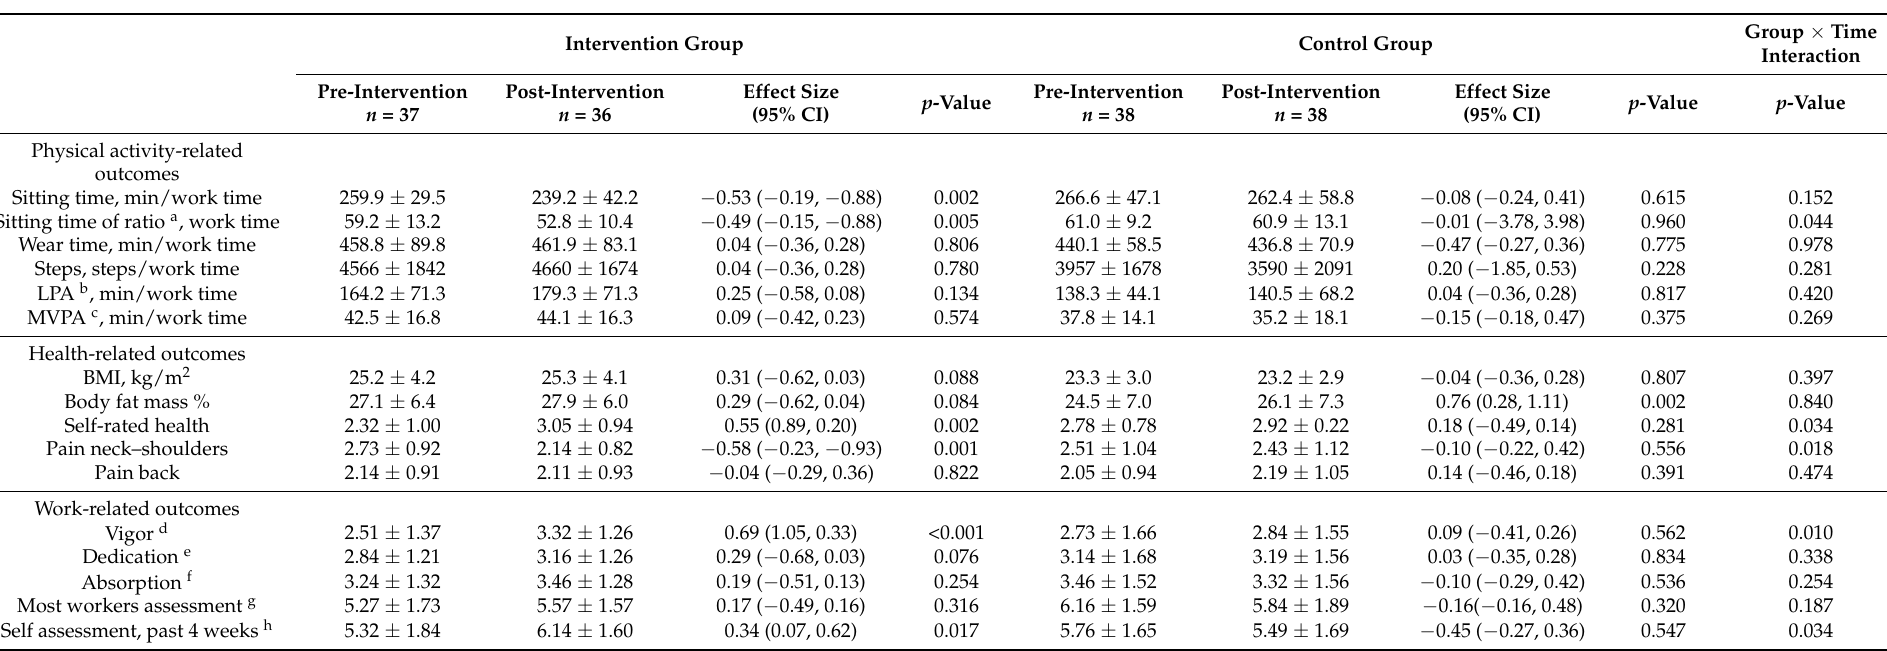
Table 2. The physical activity-, health-, and work-related outcomes at pre-intervention and post-intervention in the intervention and control groups. Group × Time Intervention Group Control Group Interaction Pre-Intervention Post-Intervention Effect Size Pre-Intervention Post-Intervention Effect Size p -Value p p -Value n = 38 n = 38 n = 37 n = 36 (95% CI) (95% CI)